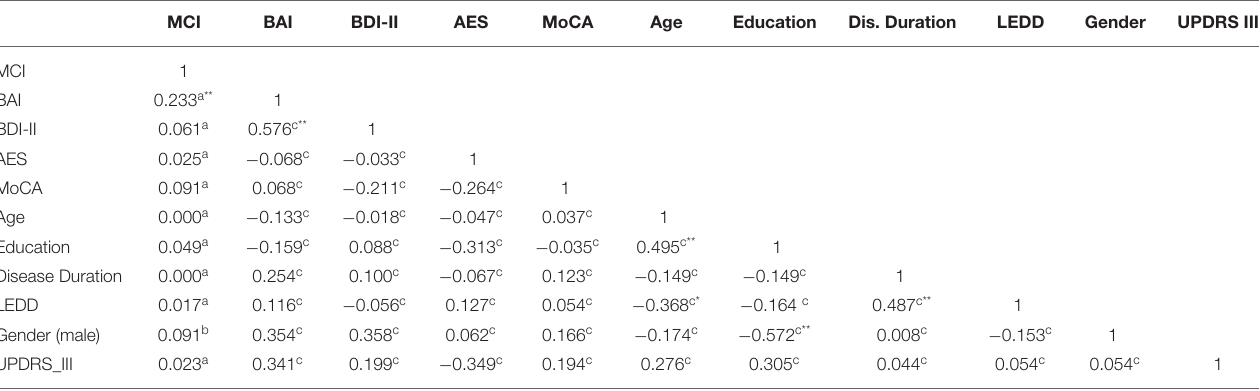
TABLE 2 | Correlations.